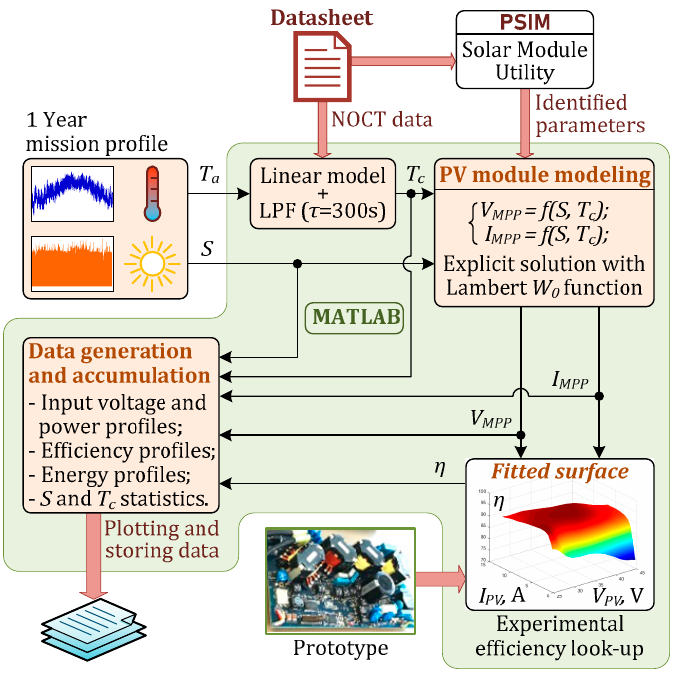
Figure 8. Flow diagram of the estimation of the annual energy production. Table 2. Nomenclature.